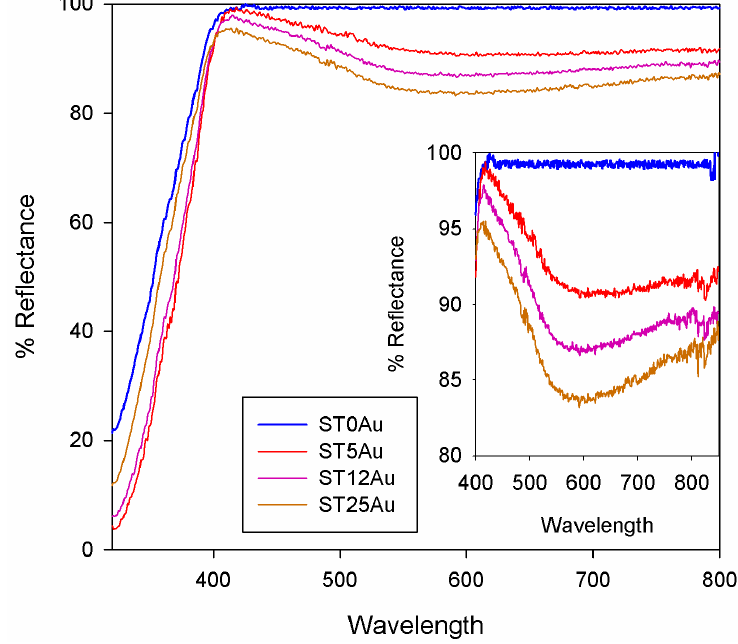
Figure 2. Reflectance UV-Vis spectra of powdered photocatalysts. Inset, detail of visible range.